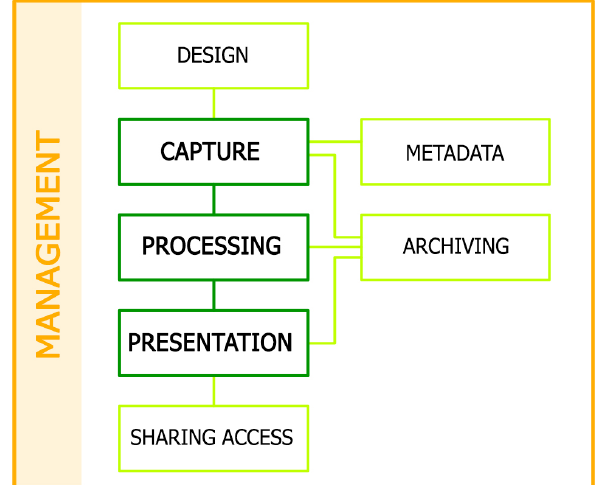
Figure 1. Outline of a digitization